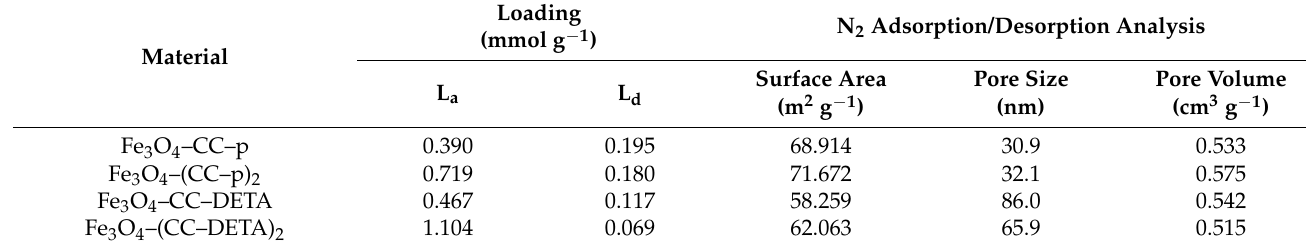
Table 1. The amine groups loading and the porous properties of the final triazine dendron-functionalized materials. Material